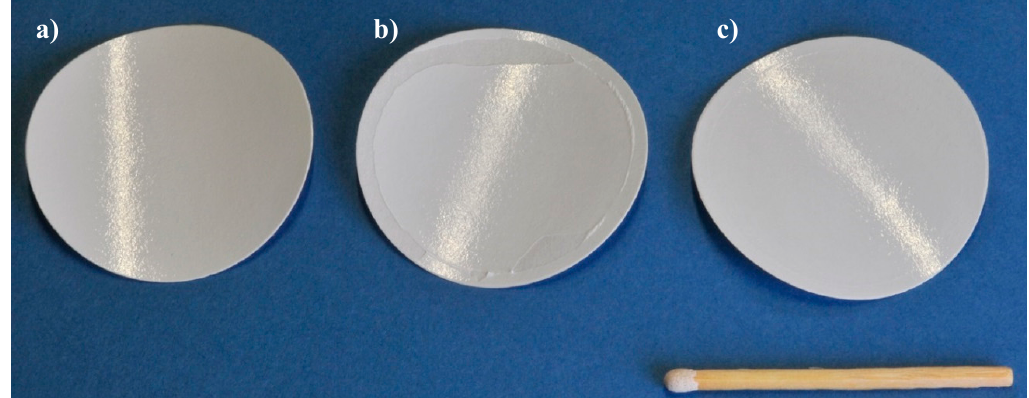
Figure 11. Samples used for the two experiments; ( a ) new sample; ( b ) sample 1 after exposure for 113 h; ( c ) sample 2 after exposure for 335 h.